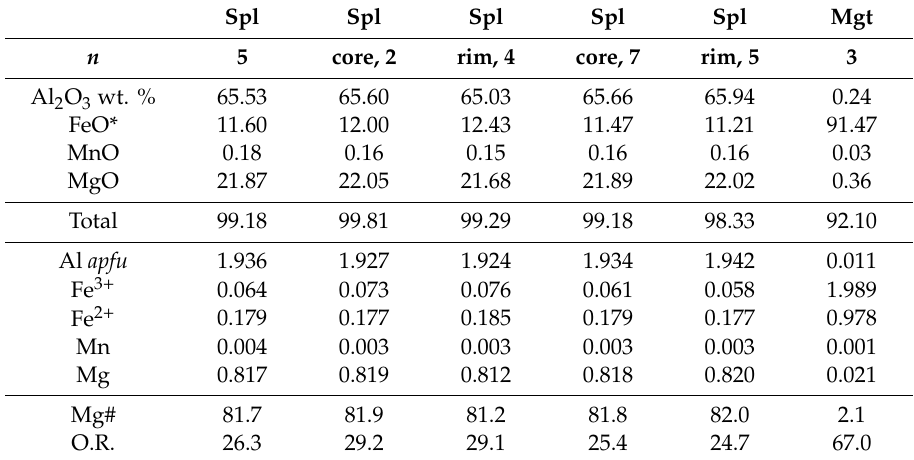
Table 2. Composition of spinel and magnetite, Parker phlogopite mine, Notre-Dame-du-Laus, Qu é bec. Spl Spl Spl Spl Spl